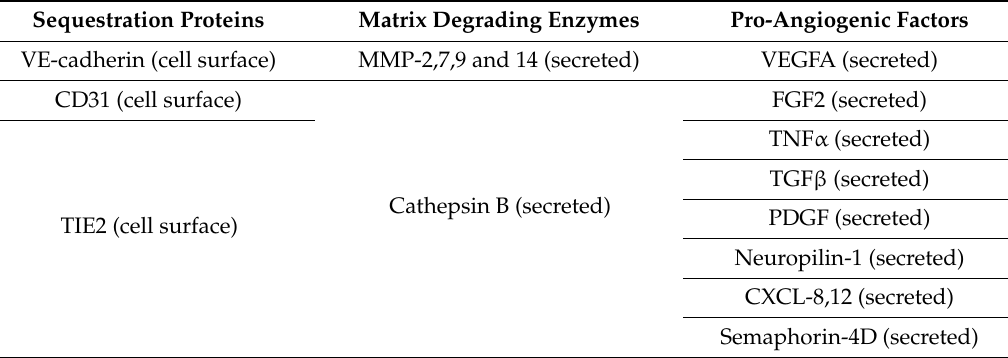
Table 1. Myeloid cells employ a number of different mechanisms to facilitate angiogenesis. Specific cell surface proteins allow myeloid cells to congregate efficiently around budding endothelium. Secreted factors include some matrix-degrading enzymes, which degrade the extracellular matrix (ECM), effectively clearing the way for budding vasculature and releasing vascular endothelial growth factor A (VEGFA) from the matrix. Lastly, myeloid cells secrete pro-angiogenic factors that stimulate endothelial cell (EC) migration and